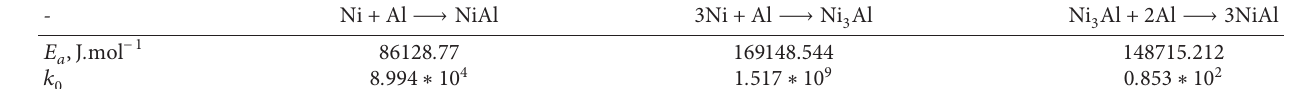
Table 1: Formal-kinetic parameters of reactions.